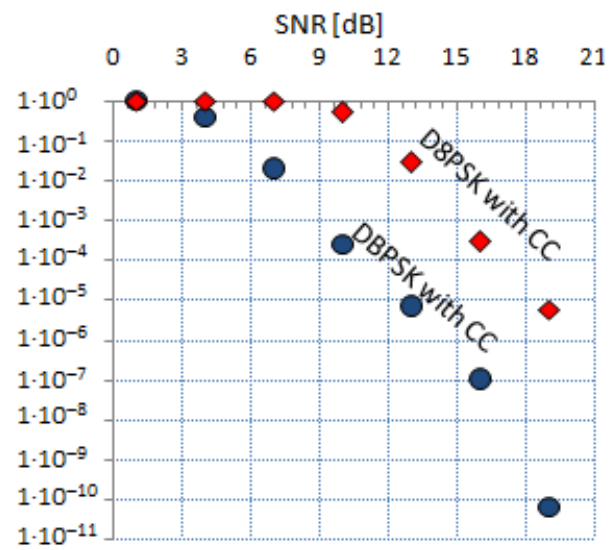
Figure 1. FER vs. SNR characteristics, for DBPSK with CC, and D8PSK with CC modulations, performed with the frame size of 18